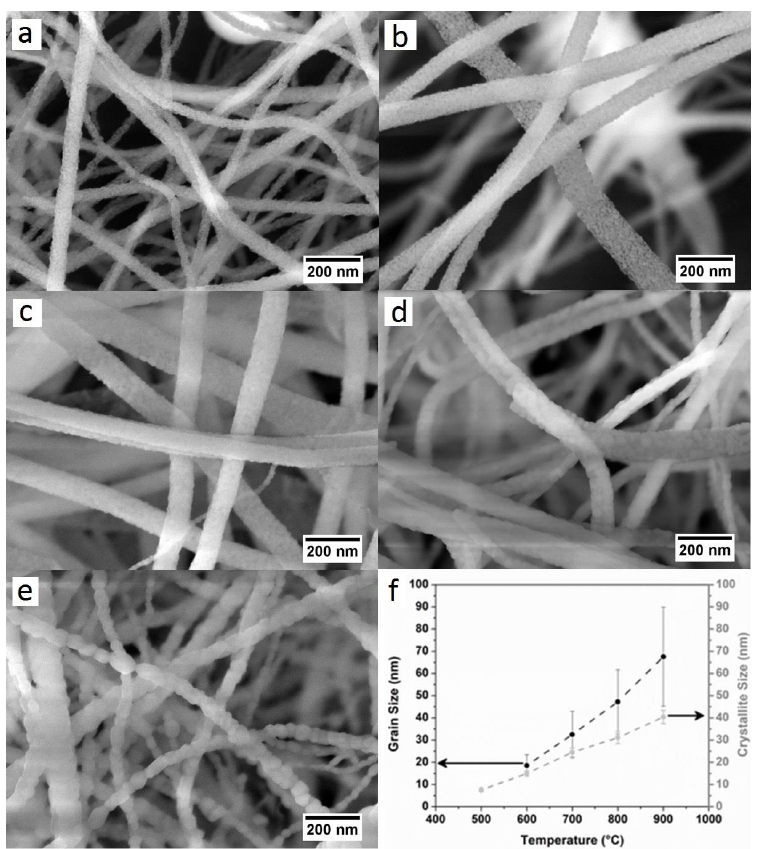
Figure 2. SEM images for the different samples: ( a ) CGO500, ( b ) CGO600, ( c ) CGO700, ( d ) CGO800, and ( e ) CGO900; ( f ) evolution of crystallite and grain sizes with the calcination temperatures.